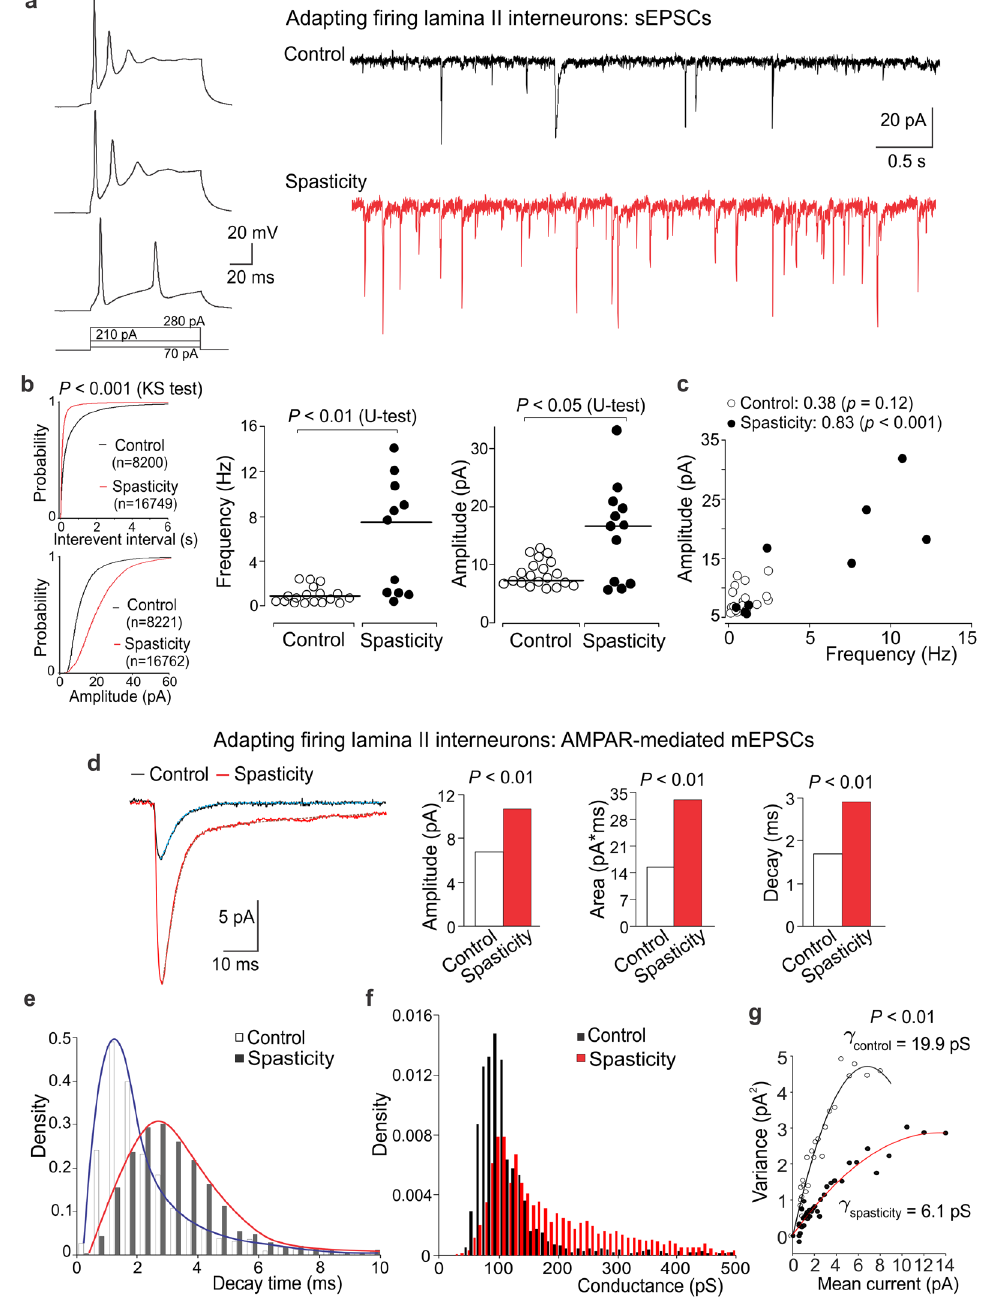
Figure 3. Boosted excitatory drive and upregulated postsynaptic AMPARs in AFNs post-SCI. ( a ) Examples of the current-clamp recordings of typical firing pattern of AFNs (left) in response to depolarizing currents (indicated on the bottom) and the voltage-clamp recordings of sEPSCs (Vh = − 70 mV) in control and spastic animals (right). ( b ) Left, cumulative probability plots for the inter-event interval and the amplitude of sEPSCs in control and spasticity. Right, scatter plots of the median sEPSC frequency and the median current amplitude estimated for individual AFNs in control (n = 18 cells) and spasticity (n = 11 neurons). The Kolmogorov- Smirnov (KS) or the Mann-Whitney U-test significance is indicated. ( c ) The median sEPSC frequency plotted against the median current amplitude for individual AFNs in control and spasticity. The Spearman correlation coefficients with the Spearman’s non-parametric test significance are indicated. ( d ) The averaged AMPAR- mediated mEPSCs (left) and summary for the median current amplitude, area, and the decay kinetics (right) in control and spasticity. The Mann-Whitney U-test significance is indicated. ( e , f ) The probability density functions for the decay kinetics of postsynaptic AMPAR-mediated currents ( e ) and the estimated AMPAR- conductance ( f ) in AFNs in control and spasticity. ( g ) The single-channel conductance of postsynaptic AMPARs in AFNs in control (n = 6 cells, 453 currents) and spasticity (n = 4 cells, 670 currents). The bootstrap hypothesis test for two-sample problem is